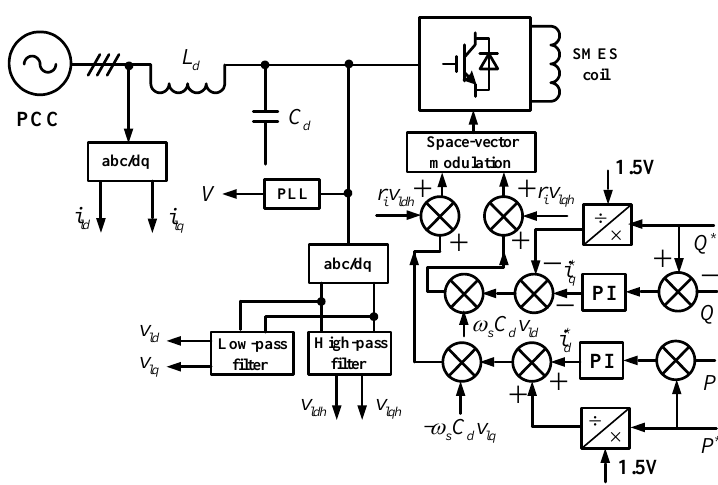
Figure 5. Control block diagram of the SMES unit for achieving energy compensation. PI: proportional integral.